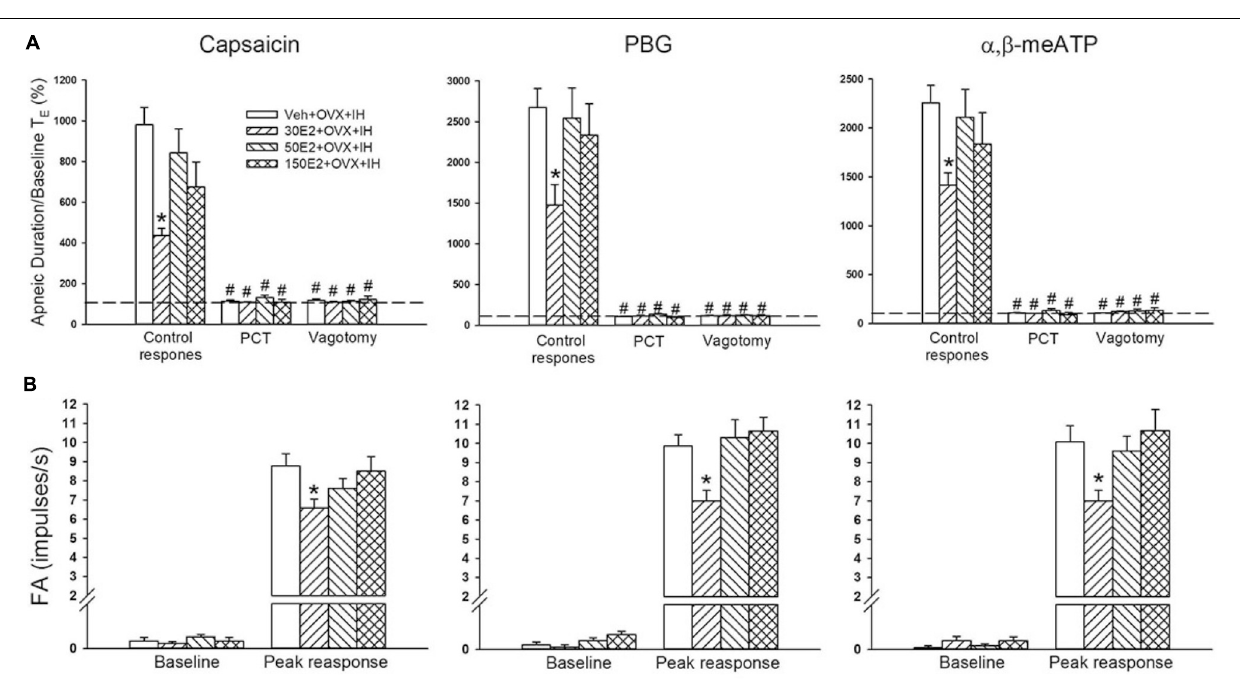
FIGURE 5 | Role of estrogen in the potentiating effect of OVX on apneic responses and afferent responses to stimulants in female rats exposed to IH. Apneic responses (A) and afferent responses (B) to intravenous capsaicin, PBG, and α , β -meATP were measured after 14 days of exposure to IH in OVX rats supplemented with vehicle (Veh + OVX + IH) or three different concentrations of 17 β -estradiol (E2): 30, 50, and 150 µ g/ml (30E2 + OVX + IH, 50E2 + OVX + IH, 150E2 + OVX + IH). ∗ p < 0.05 compared with Veh + OVX + IH rats; # p < 0.05 compared with control responses in the same group. Data in each group are presented as means ± SE of 10 rats. See legend of Figures 2 and 4 for further